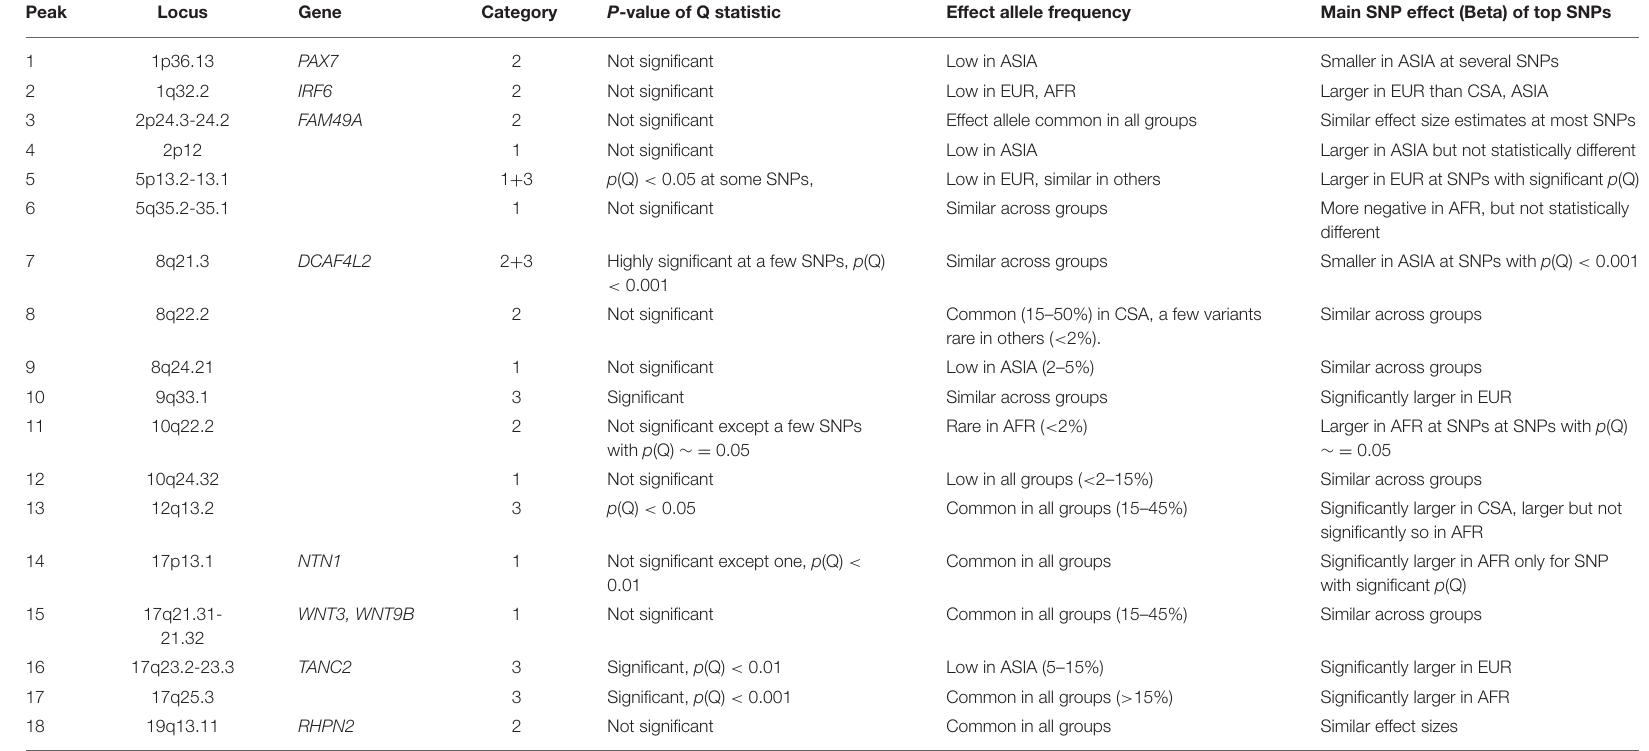
TABLE 4 | Comparison of effect allele frequency and effect size of lead SNPs within each